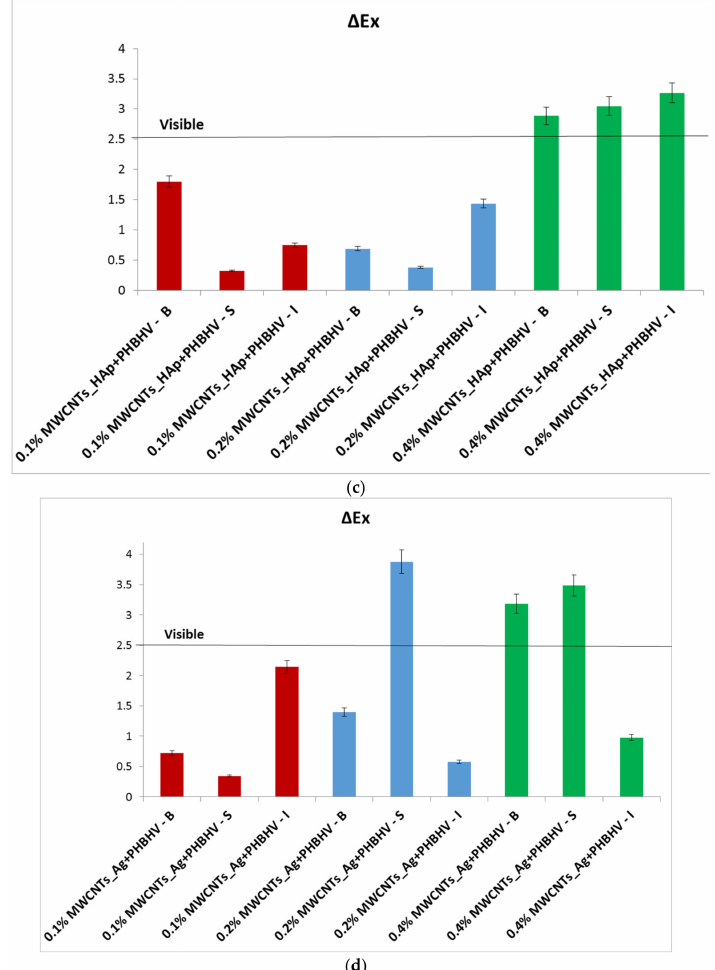
Figure 5. Total color difference calculated ( ∆ E x ): ( a ) MWCNTs + PHBHV set, ( b ) MWC- NTs_ZnO + PHBHV set, ( c ) MWCNTs_HAp + PHBHV set and ( d ) MWCNTs_Ag + PHBHV set. The results are presented as the mean ± S.D. of three